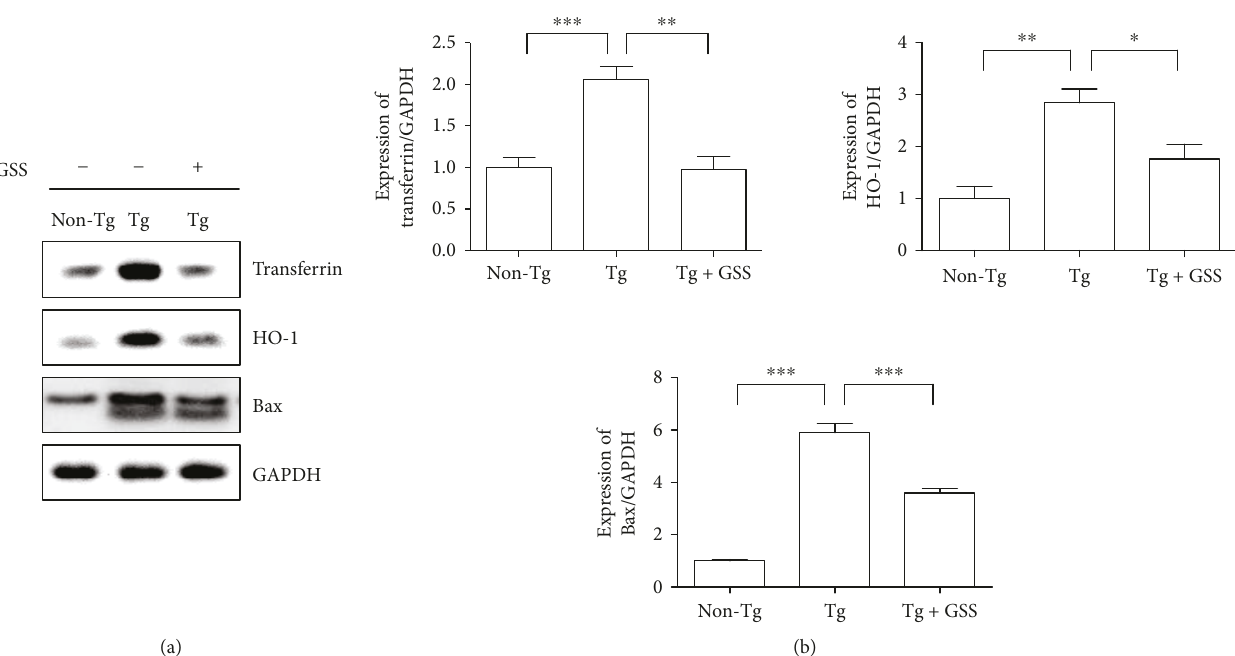
Figure 3: GSS treatment reduces oxidative stress in the spinal cord of hSOD1 G93A transgenic (Tg) mice. (a) Representative images showing the expression levels of transferrin, HO-1, and Bax in the spinal cord of control (Non-Tg), hSOD1 G93A Tg, and GSS-treated Tg mice (Tg+GSS). GAPDH was used to control for protein loading. (b) Quanti fi cation of the expression of transferrin, HO-1, and Bax. Data were normalized to GAPDH and represent the means ± SEM ( n = 4 ). Statistical assessment was performed by one-way ANOVA and Newman-Keuls ’ post hoc test. ∗ p < 0 05 , ∗∗ p < 0 01 , and ∗∗∗ p < 0 001